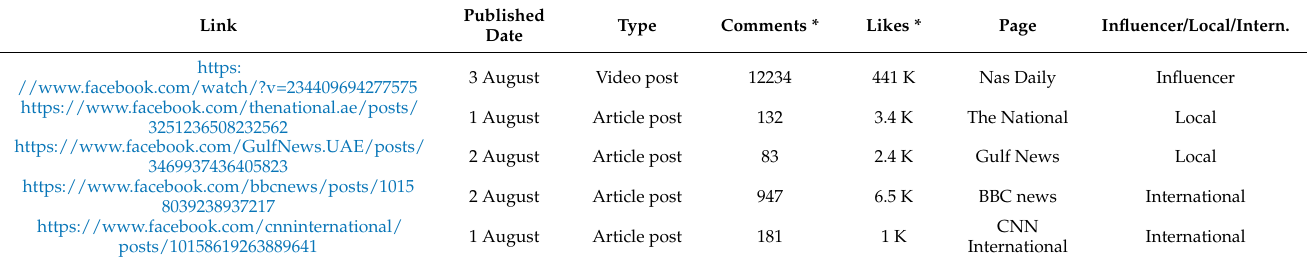
Table 1. List of Facebook posts considered for